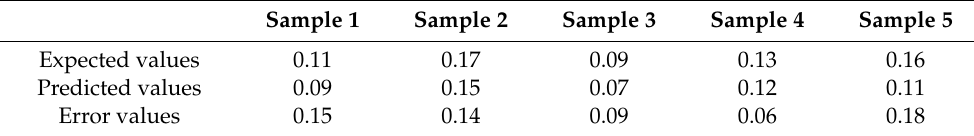
Table 3. Prediction results and error values of the AdaBoost-BP algorithm.